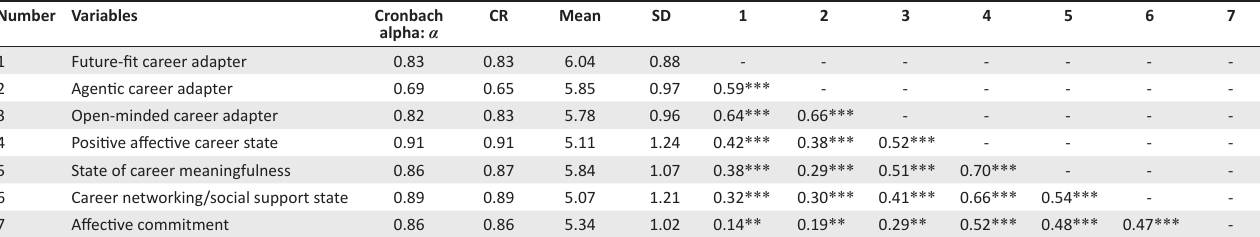
TABLE 1: Descriptive statistics and bi-variate correlations ( n = 298). Number